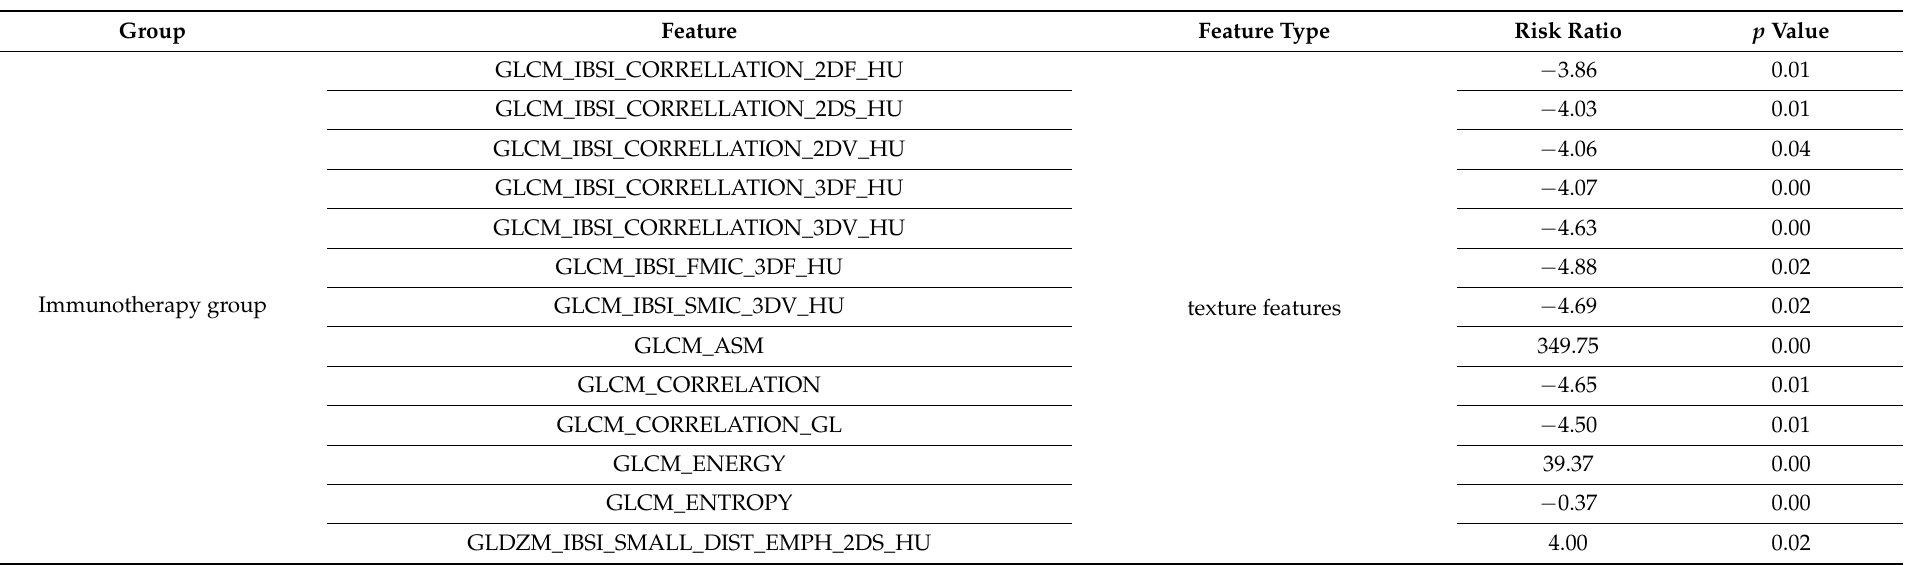
Table 3. Significant radiomic features in Cox regression analysis with risk ratio value based on PFS time stratification (short and log PFS